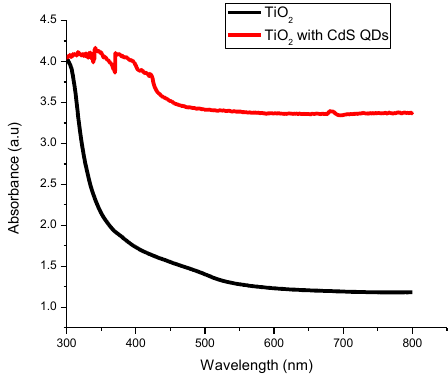
Figure 1. UV-Vis absorption spectra of titanium dioxide (TiO 2 ) and cadmium sulfide quantum dot (CdS QD) based on screen-printed TiO 2